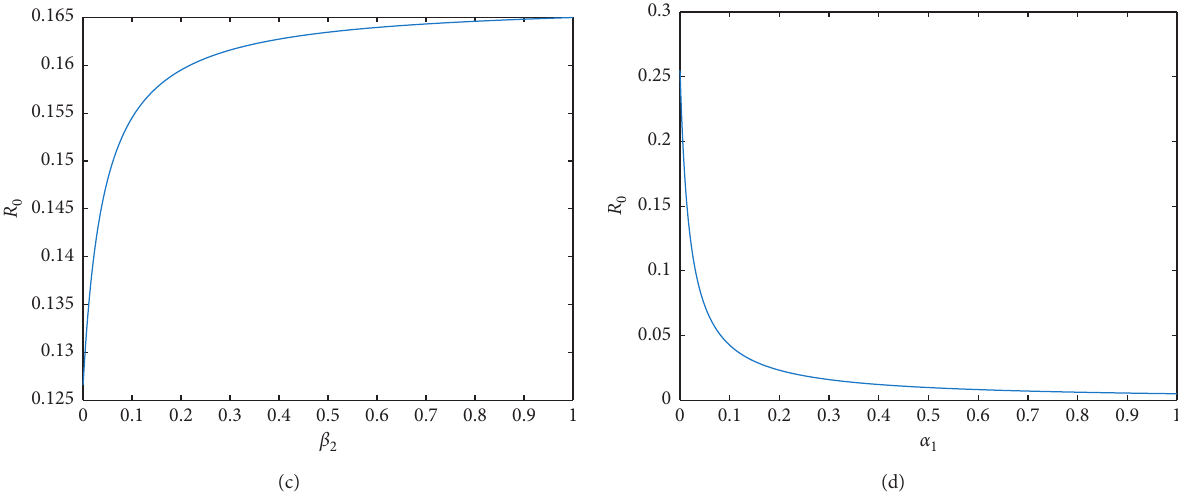
Figure 5: The relationship between R and some parameter values. (a) The relationship between R 0 and k 1 . (b) The relationship between R 0 0 and k 2 . (c) The relationship between R 0 and β 2 . (d) The relationship between R 0 and α 1 .